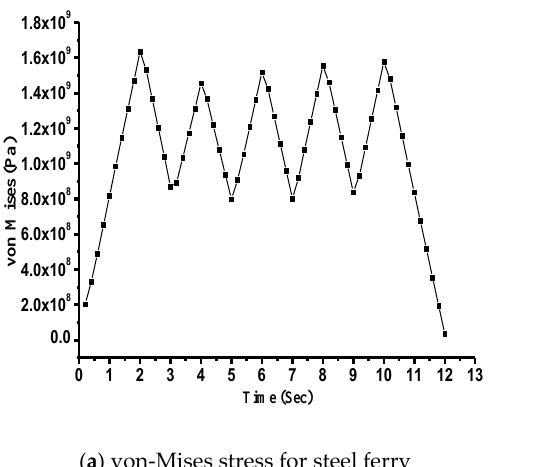
( b ) The composite ferry